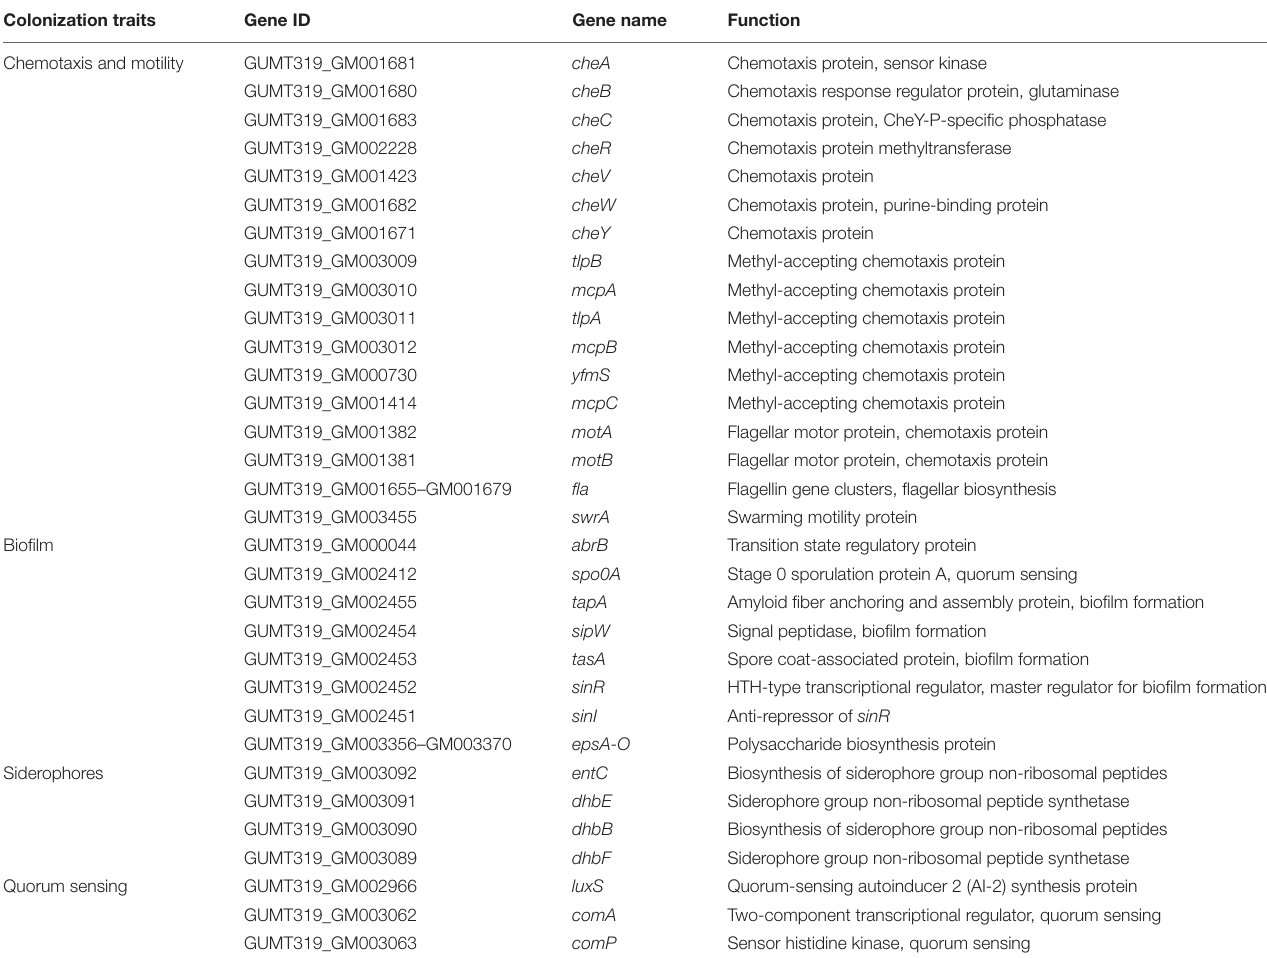
TABLE 3 | List of root colonization-associated genes identified in the GUMT319